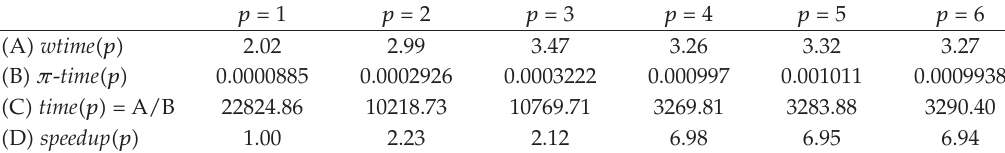
Table 7: Solver phase speedup using a relative time (cid:2) p (cid:3) : example for matrix 2cubes